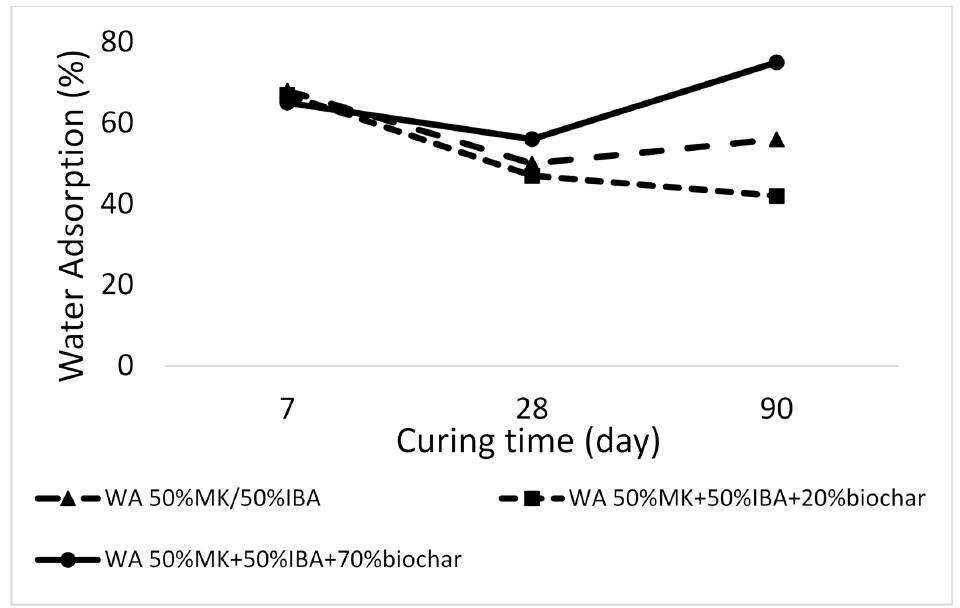
Figure 12. WA trend of 50% MK-50% IBA + Biochar at 7, 28, 90 days of curing.